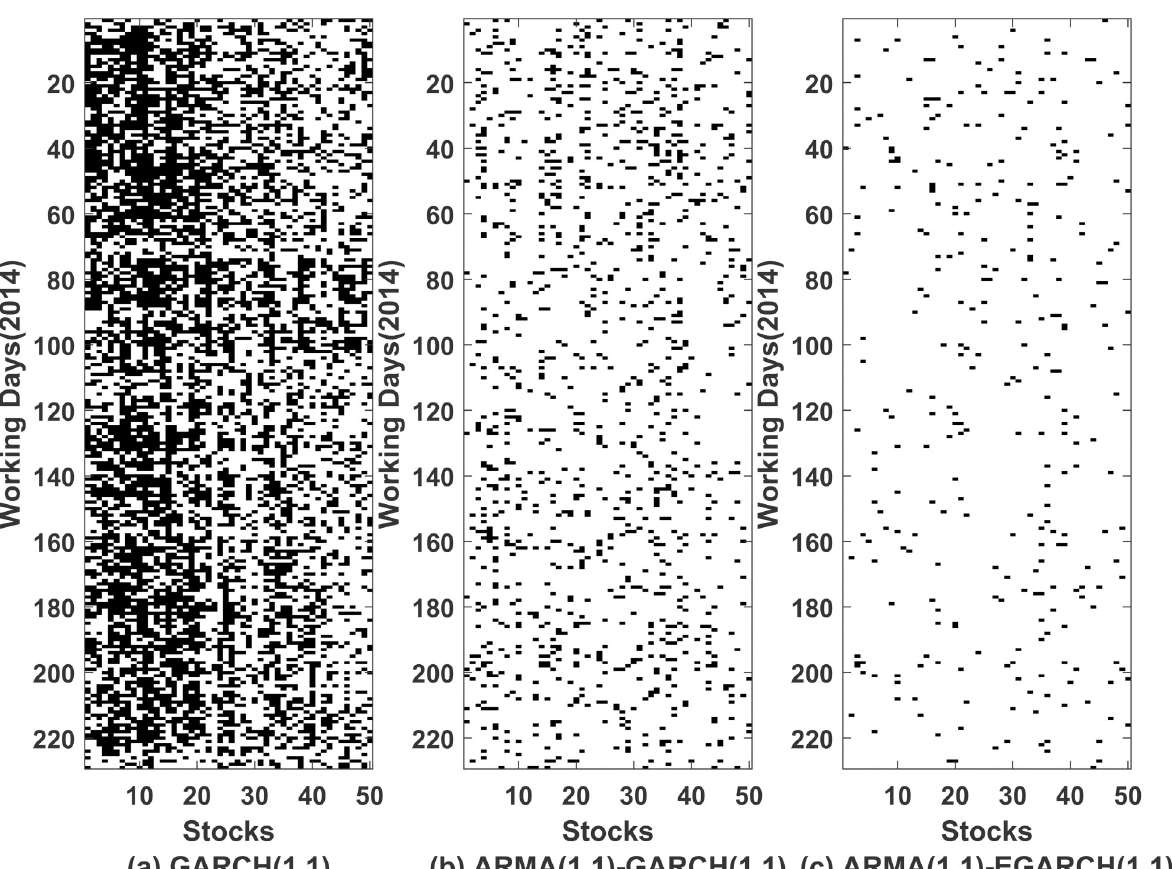
Fig 4. Ljung-Box test on errors. On horizontal axis we have listed 50 stocks and on vertical axis we have working days of year 2014. Black and white colour represents that the null hypothesis ( H 0 : data is independent , H A : data exhibit serial correlation ) is rejected or accepted respectively. (a), (b) and (c) corresponds to test applied to the error terms( � ) in GARCH(1,1), ARMA(1,1)-GARCH(1,1) and ARMA(1,1)-EGARCH(1,1) models t , k respectively.